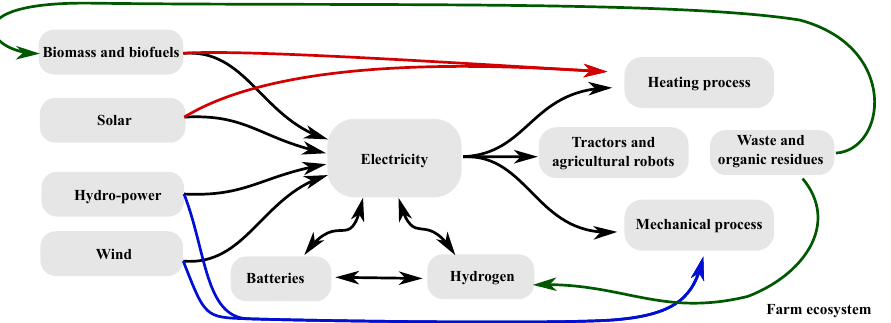
Figure 3. The schematic vision of an energy-independent farm